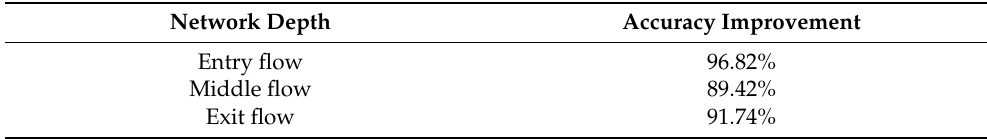
Table 2. Channel attention test in different